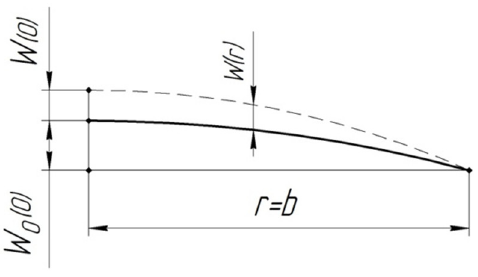
Figure 9. Deflection diagram.